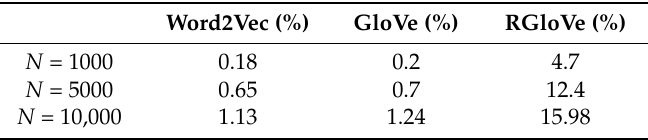
Table 2. Top N precision.